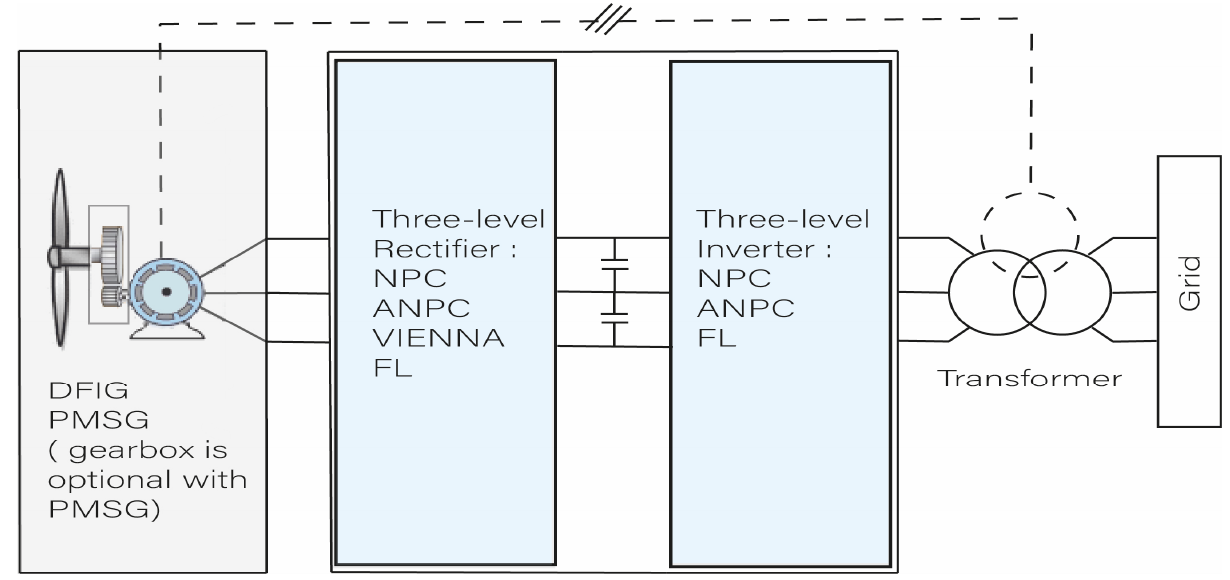
Figure 1. Wind turbine system configuration based on DFIG or PMSG.